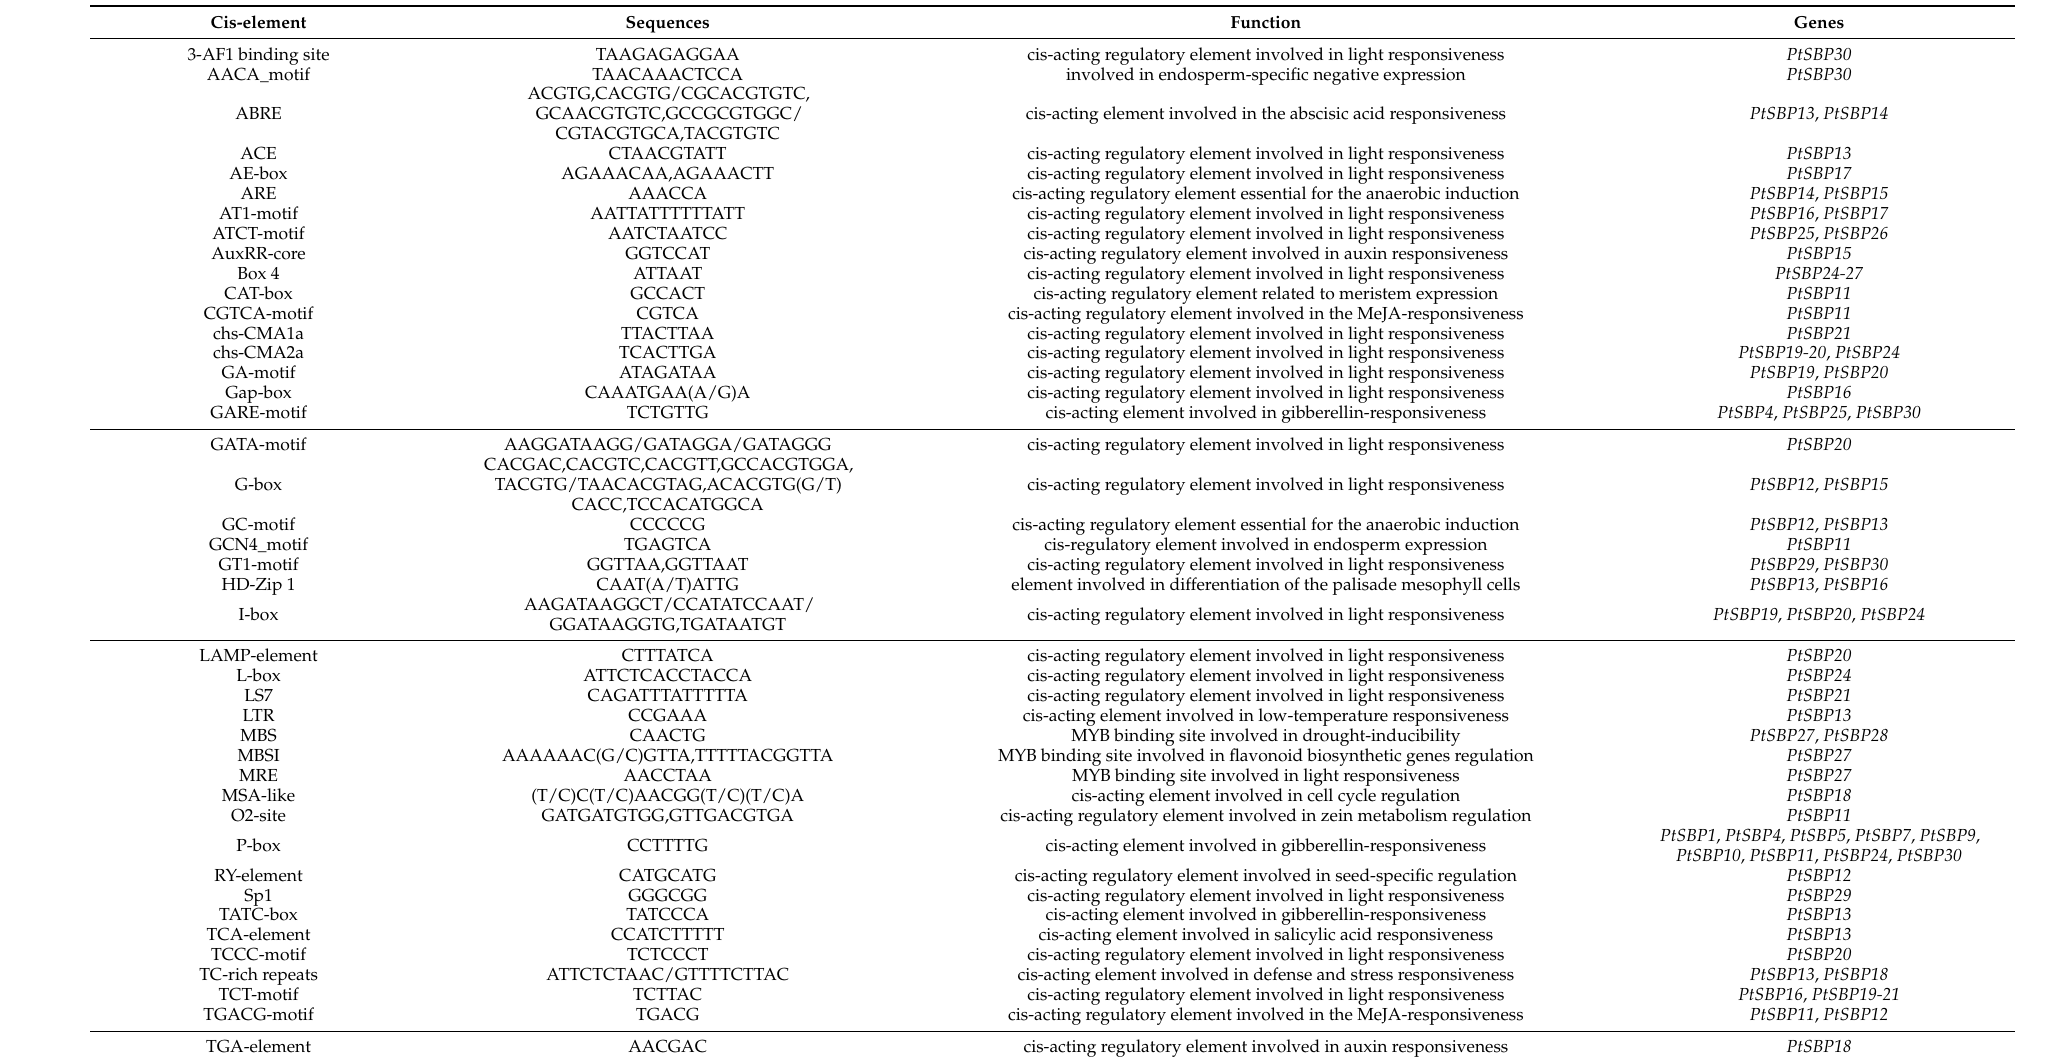
Table 3. Cis-acting regulatory element in promoter of PtSBP